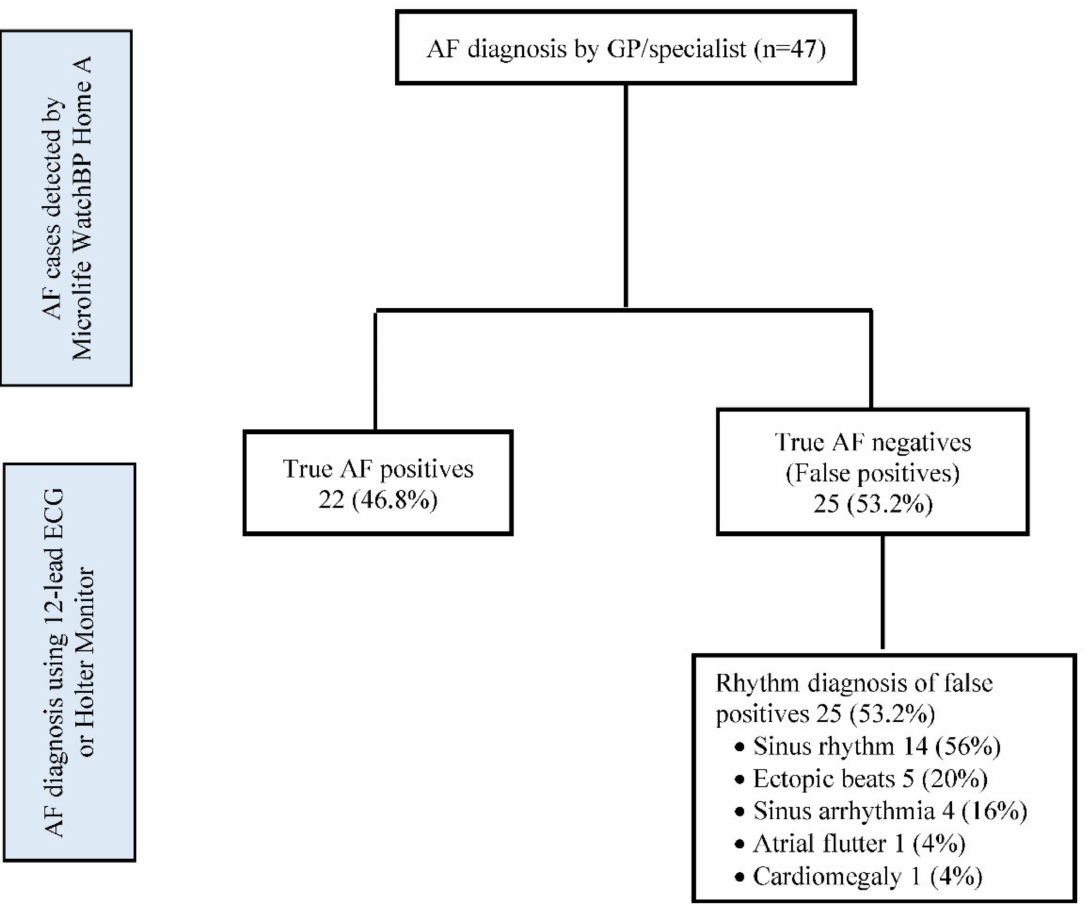
Figure 1. Diagnostic performance of Microlife WatchBP Home A (Positive predictive value of Microlife WatchBP Home A; 22/47 =